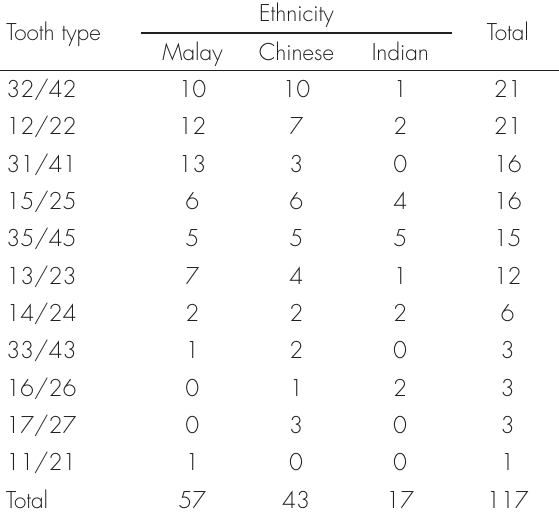
Table IV. Missing teeth according to